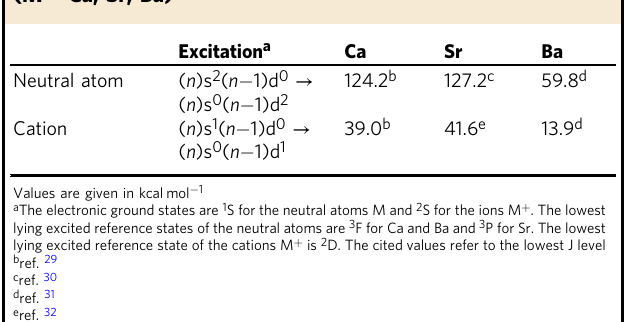
Table 3 Experimental excitation energies of the alkaline atoms M and ions M + from the electronic ground state to the reference state in the complexes M(N 2 ) 8 and [M(N 2 ) 8 ] +